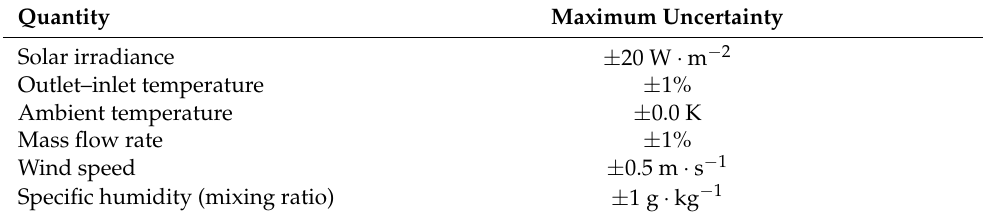
Table 1. ISO 9806:2017 uncertainty